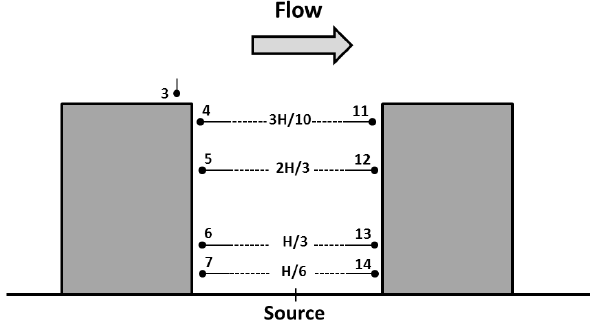
Figure 2. Location of the comparison points with the experimental measurements of Meroney et al.